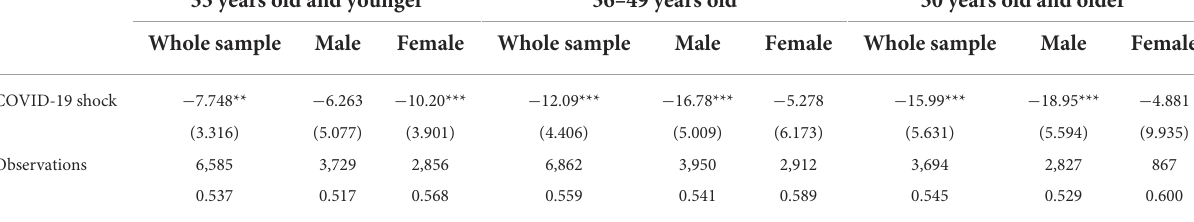
TABLE 10 Heterogeneous analysis of age.